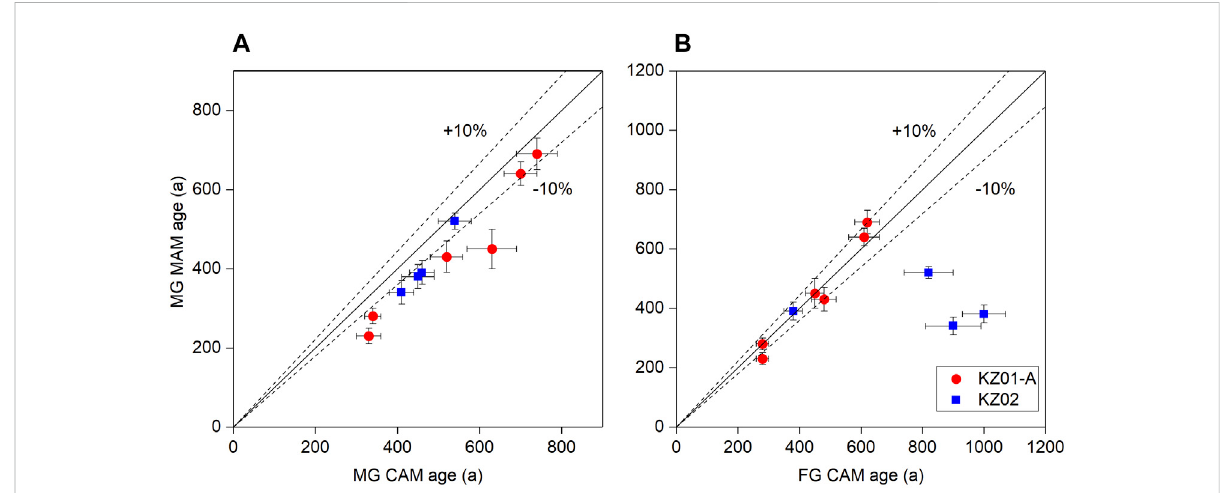
340 – 520 a in core KZ02) in these two cores (Table 1; Figure 4A; Niu et al., 2021). Supplementary Figure